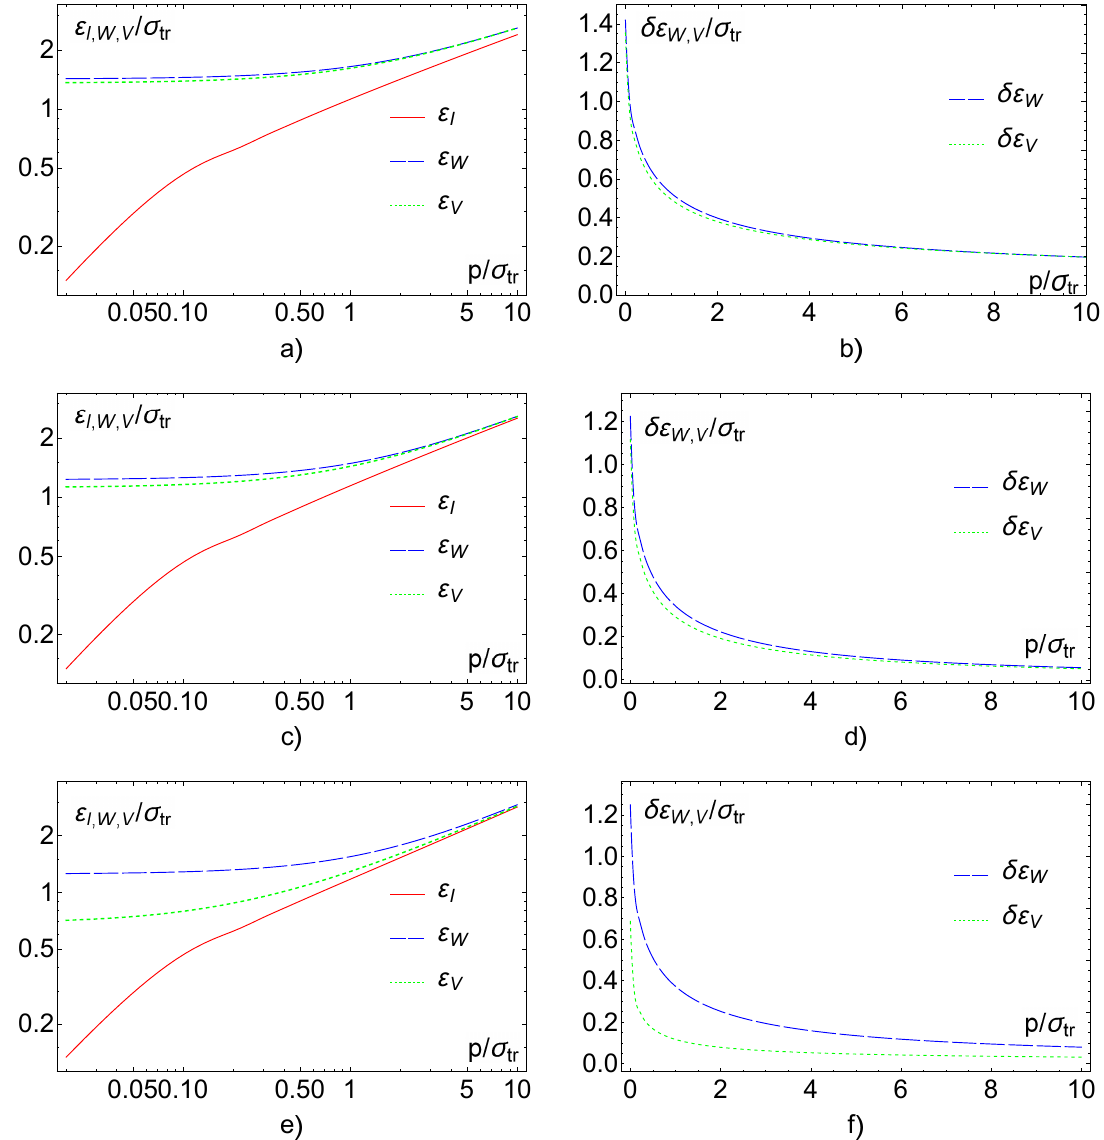
Figure 6. Eigenvalues ε I , ε W and ε V (solid, dashed and dotted lines, respectively) and differences δε W and δε V (dashed and dotted lines, respectively) versus p . The numerical calculations were carried out for ( a , b ) sea water, ⟨ cos γ ⟩ = 0.89, ( c , d ) Henyey-Greenstein phase function/Rayleigh scattering matrix, g = 0.9 and ( e , f ) aqueous suspension of polystyrene spheres ( d = 0.993 µ m, λ = 633